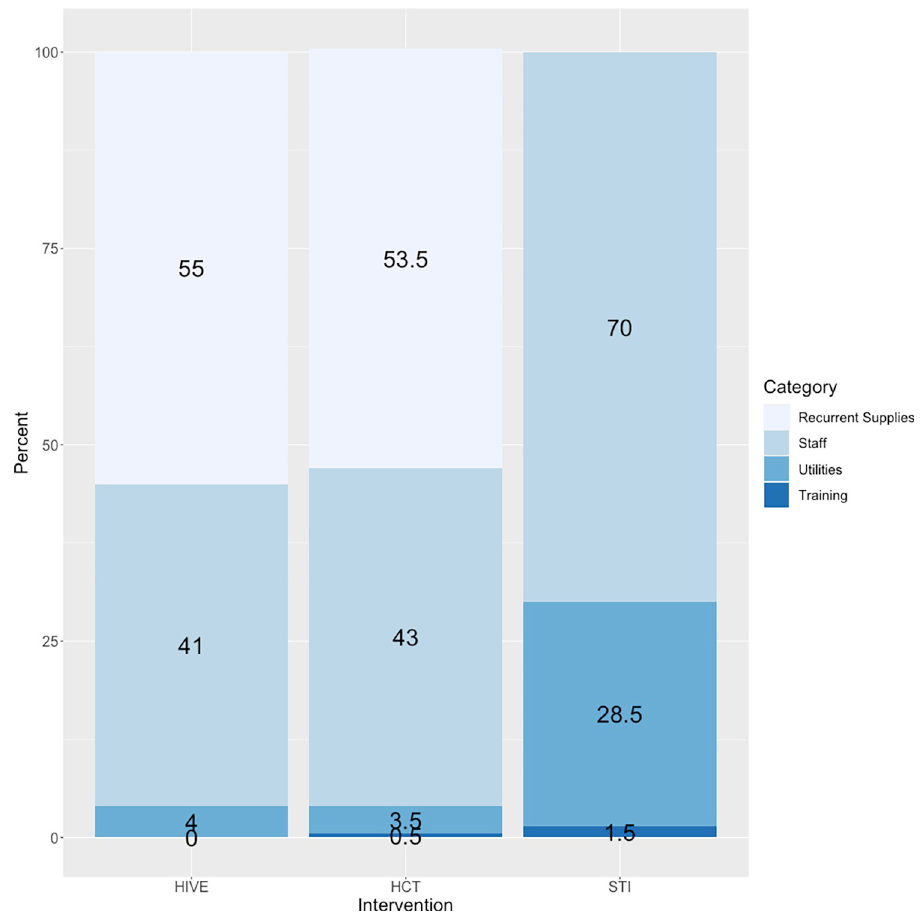
Fig 2. Program costs of a sample of Nigerian community-based organizations by intervention and input